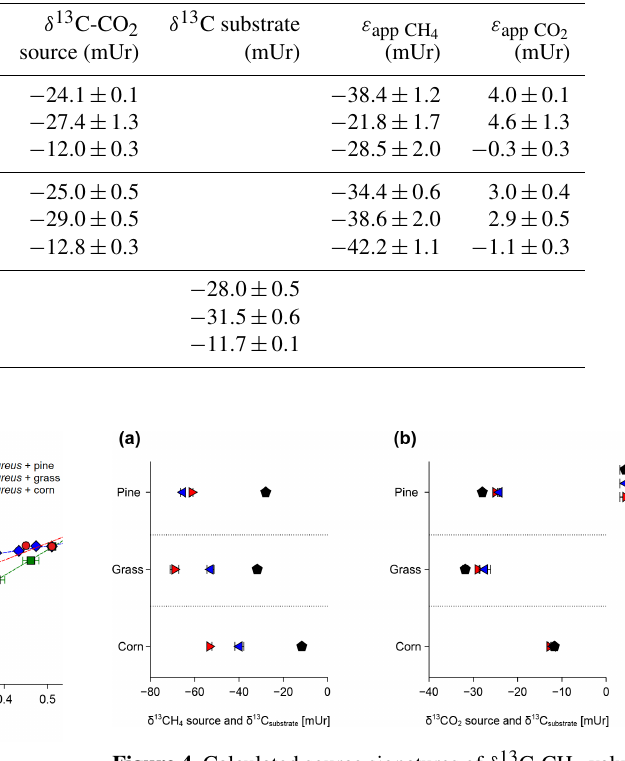
Figure 3. Keeling plots shown for P. sapidus (a) and L. sul- phureus (b) grown on the three substrates. Sample points in the graphs are given as the arithmetic mean of the δ 13 C-CH 4 or δ 13 C- CO 2 values with their standard deviation ( n = 3) on the y axis and the arithmetic mean of the inverted mixing ratio of CH 4 or CO 2 with their standard deviation ( n = 3) on the x axis.